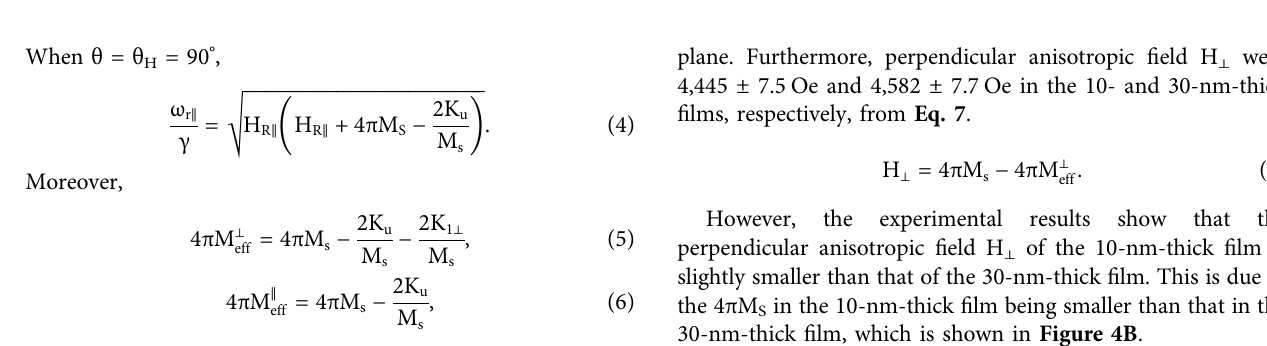
Frontiers in Materials |